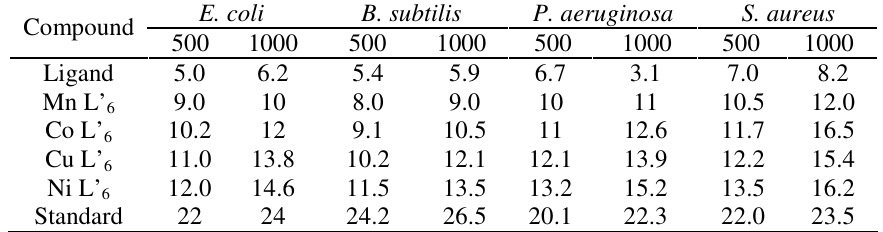
Table 4. Antimicrobial activity of compounds (Diameter of inhibition zone in mm and concentration in